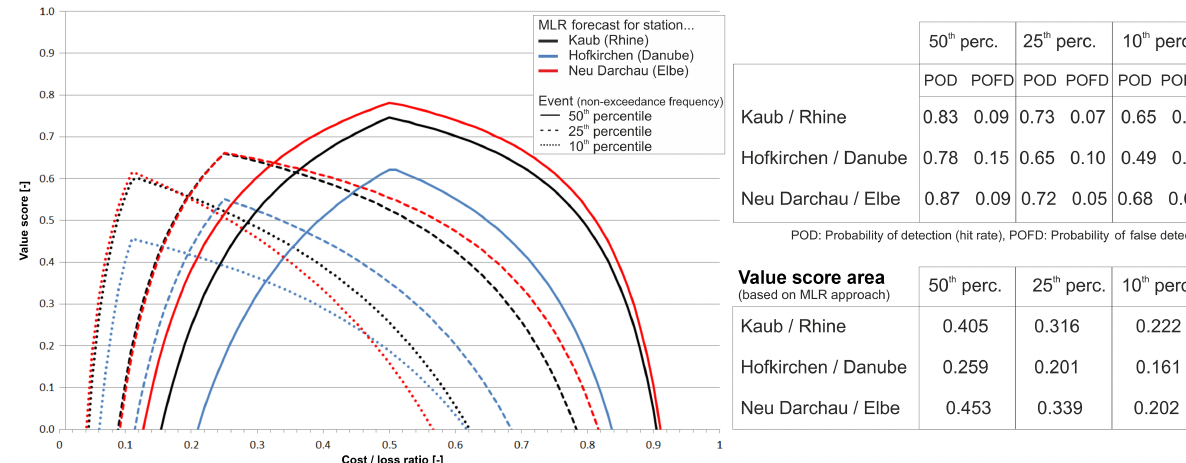
Figure 10. Economic value score plotted against cost/loss ratio for the forecast of the lowest 7-day mean flow MoNM 7 Q of the current month at the gauges Kaub/Rhine, Hofkirchen/Danube and Neu Darchau/Elbe based on the statistical approach (verification period 1951–2014).